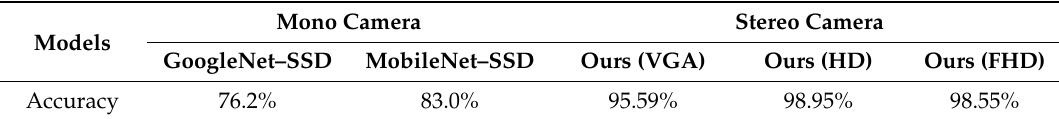
Table 3. Performance comparison for counting accuracy.